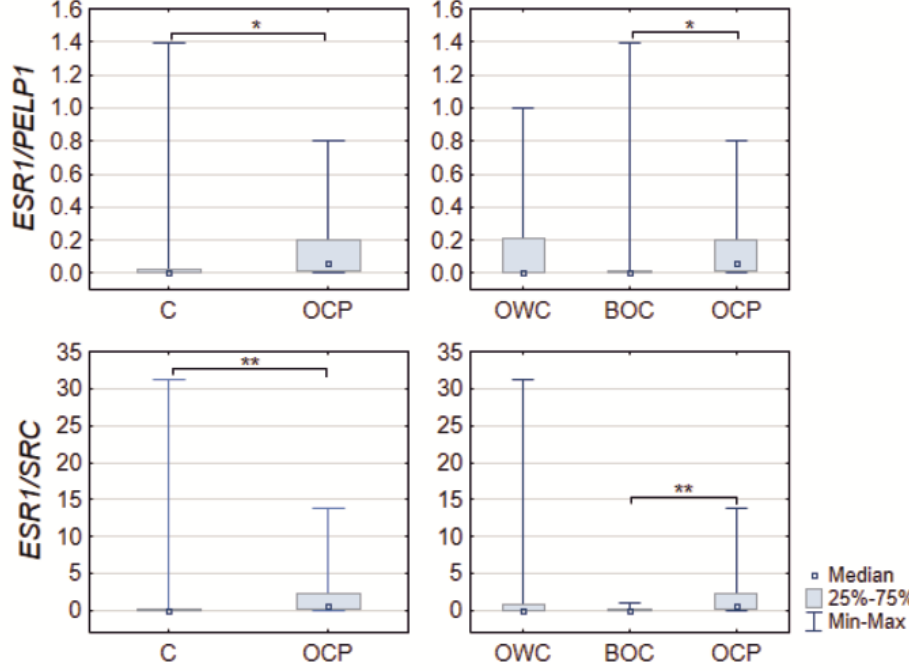
Figure 2. Boxplots of the ESR1 / PELP1 and ESR1 / SRC quotient ratios in controls (C), ovarian cancer patients (OCP), ovarian tissue samples lack of any changes patients (OWC) and with benign noncancerous changes (BOC) * p < 0.05 and ** p < 0.01. Medians, interquartile range and p -values are shown in Table 1.